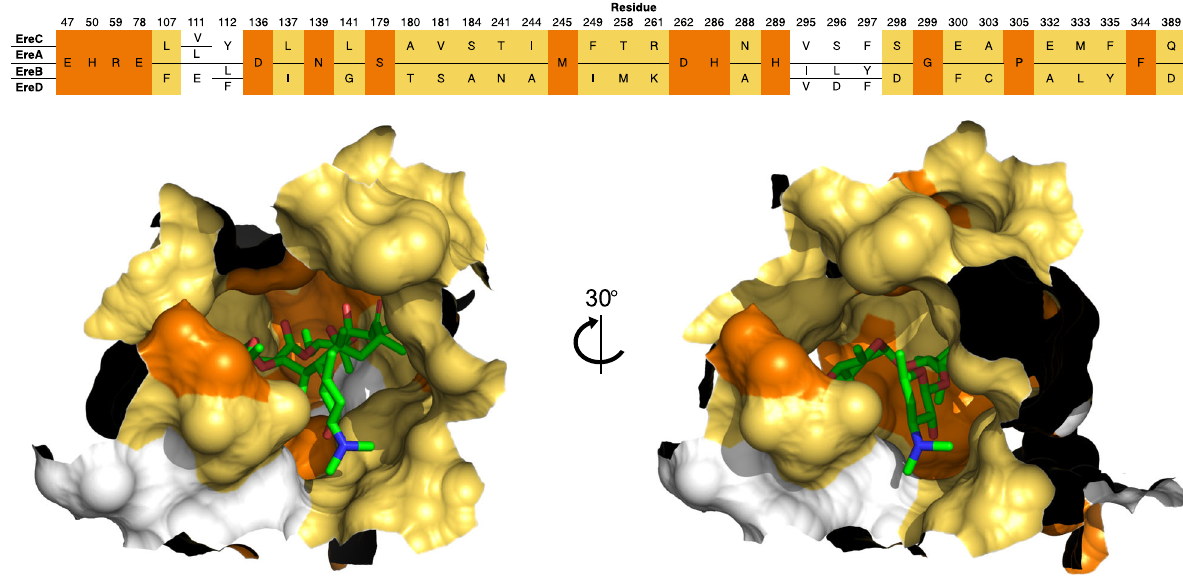
Fig. 6 Active site architecture of Eres. Upper panel: MAFFT protein sequence alignment of EreA, EreB, EreC, and EreD. The residues are colored as per sequence identity. The fully conserved residues are in orange, the residues conserved between EreA/C and EreB/D are in yellow, and variable residues are in white. Lower panel: the conservation is shown on protein sequence, as per the coloring in the upper panel, with erythromycin present as a